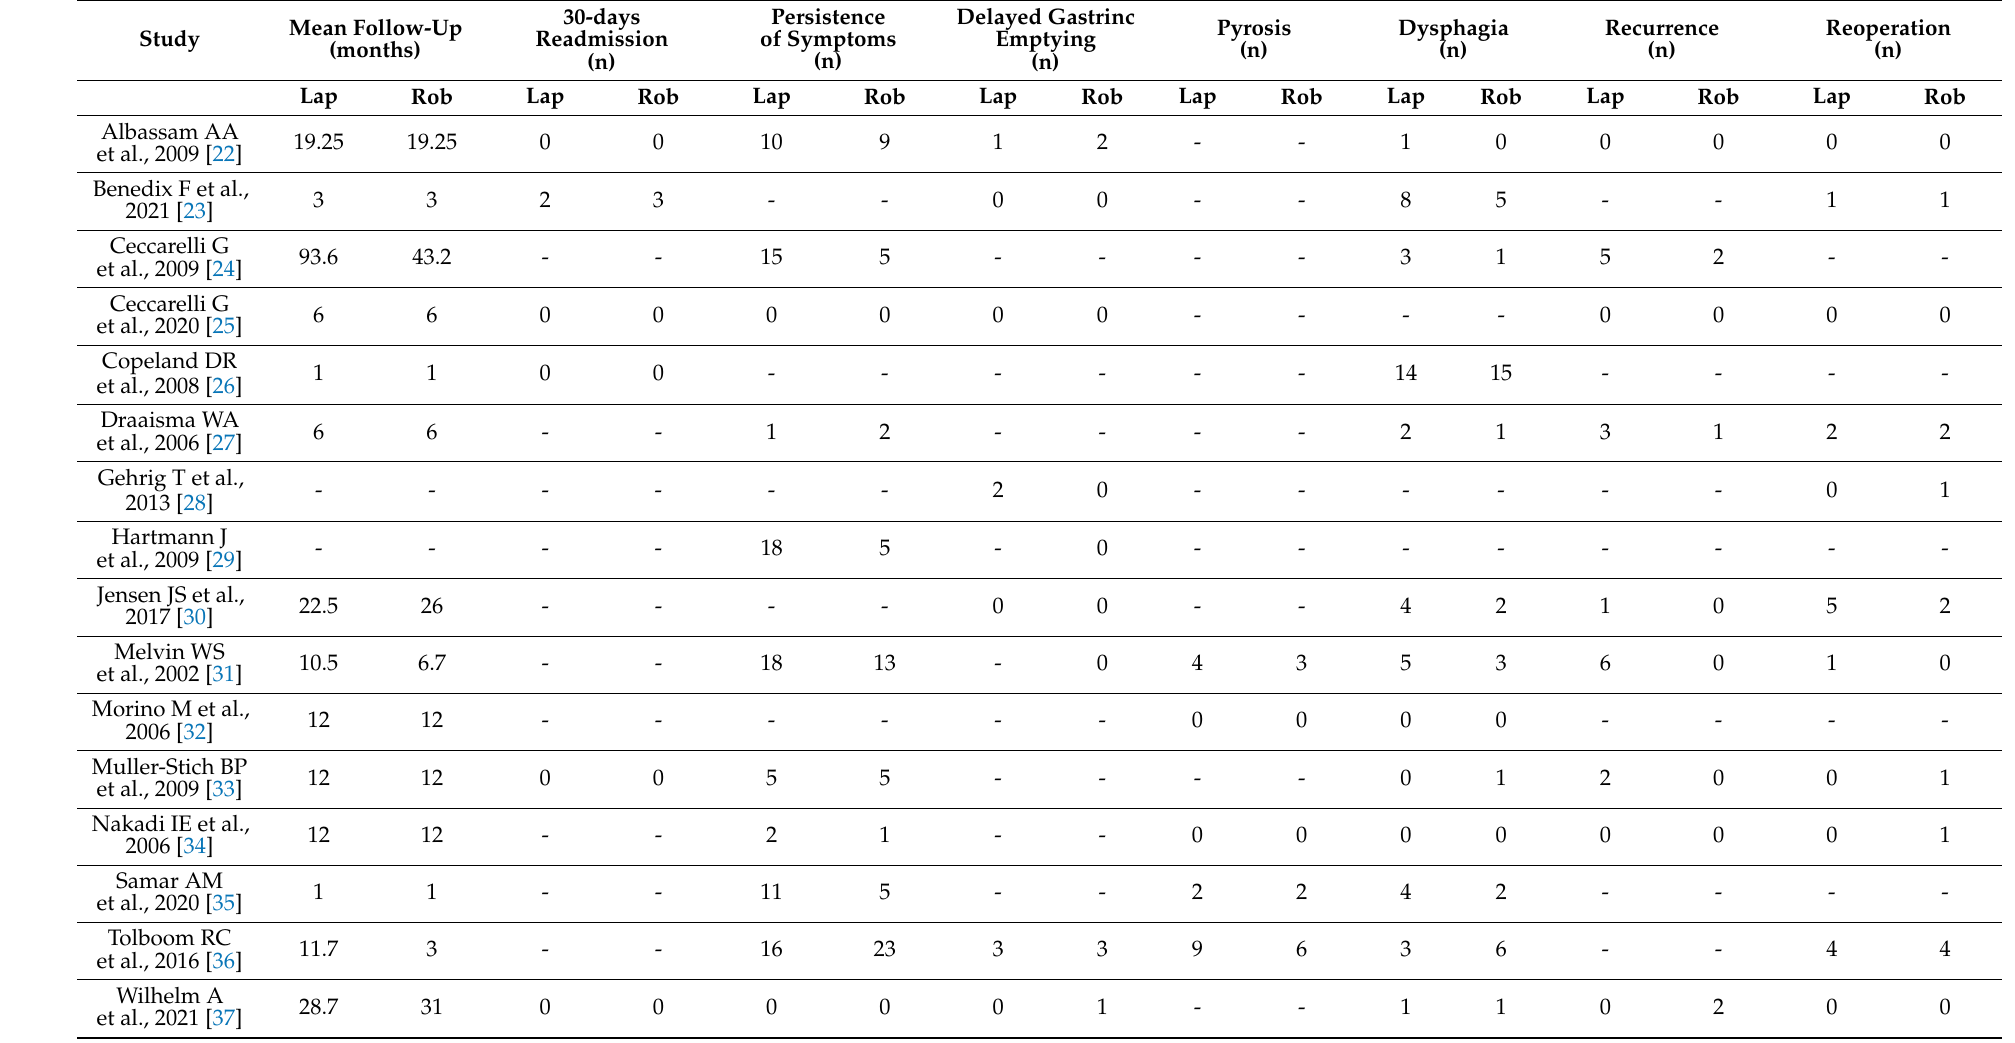
Table 3. Functional